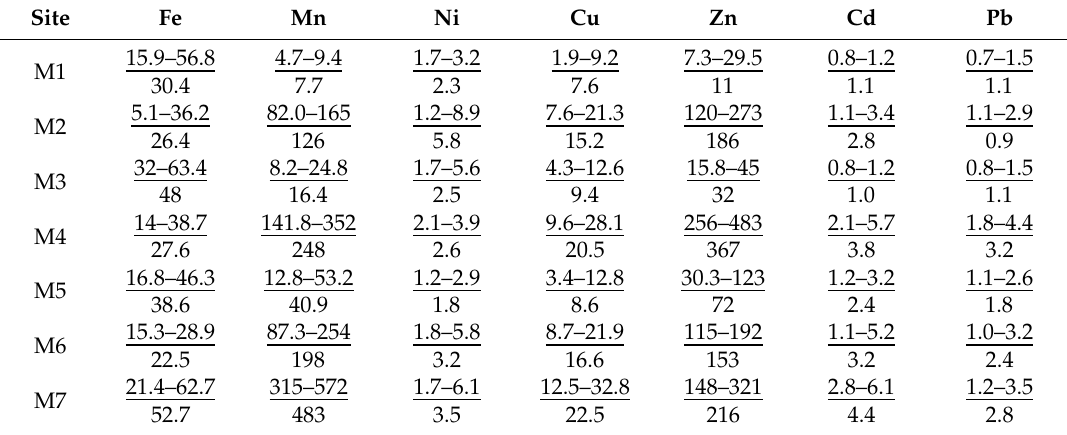
Table 4. The concentration of dissolved heavy metals ( µ g · L − 1 ); n = 15—number of samples.